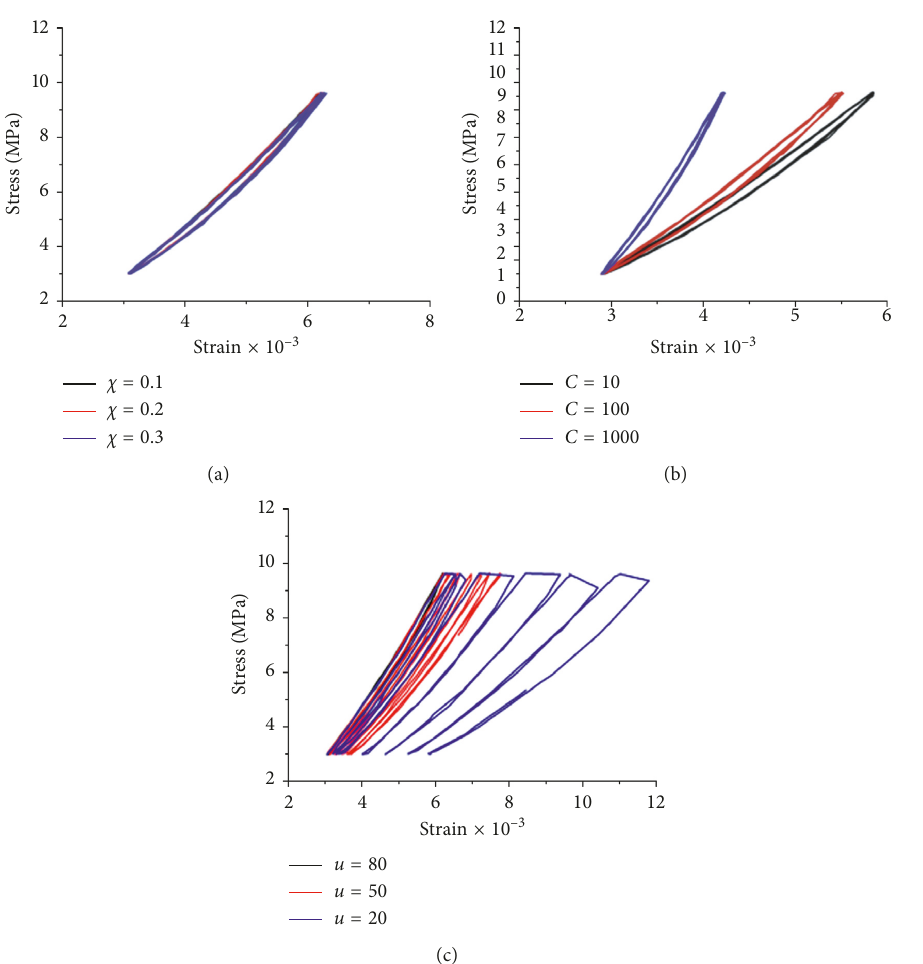
Figure 6: Influences of parameters on the subloading surface model. (a) Parameter χ . (b) Parameter C . (c) Parameter u .